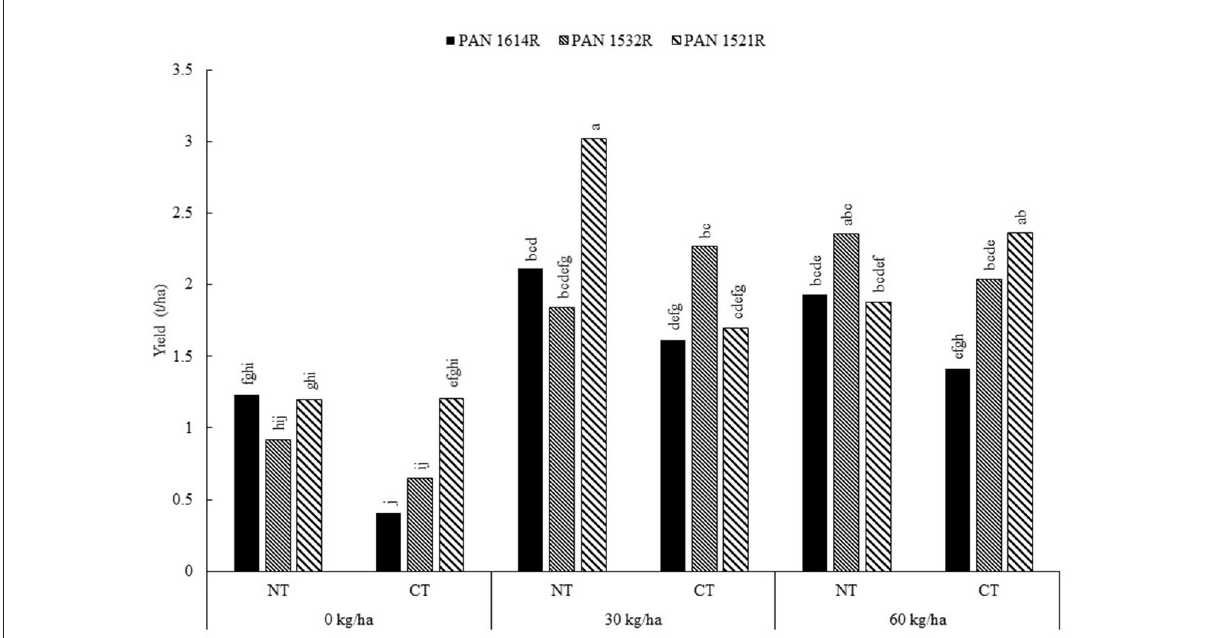
FIGURE4 Interactive effects of fertilizer, cultivar and tillage on soybean yield on a soybean cropping system. Levels with same letter are not significantly different.